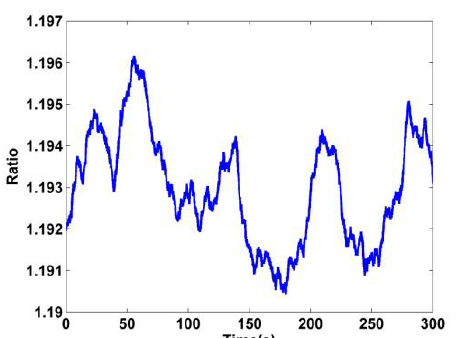
Figure 10 Comparison of XCO 2 measured by lidar and